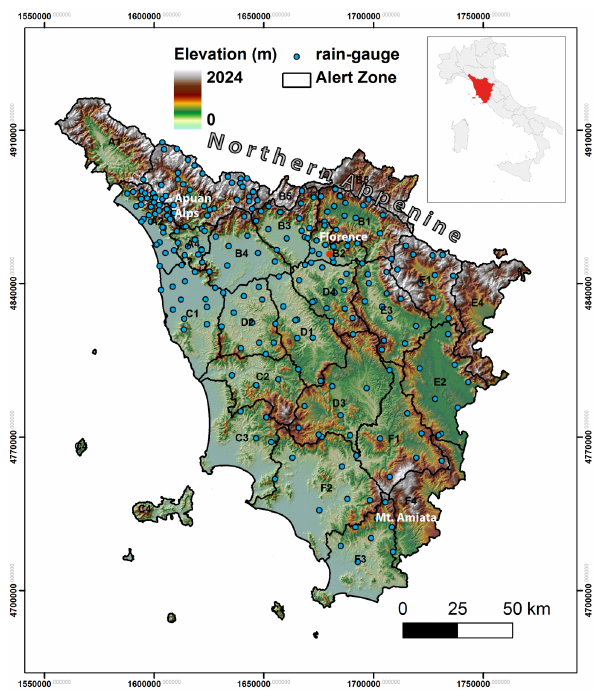
Figure 1. Study area (Tuscany, central